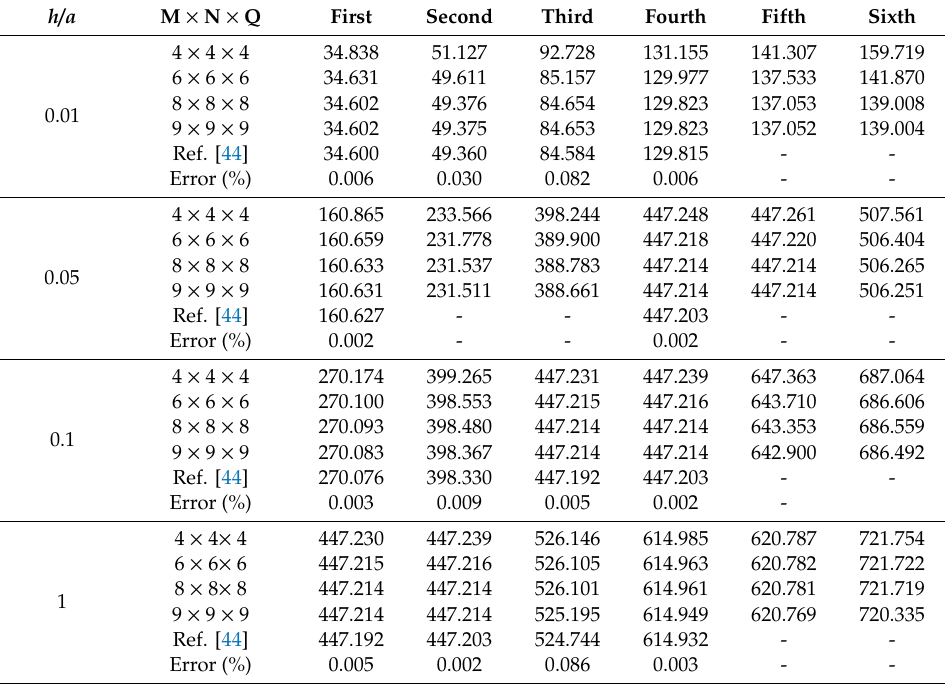
Table 2. The first six natural frequencies (Hz) of simply supported cross-ply (0 ◦ / 90 ◦ / 0 ◦ ) laminated square plate with di ff erent thickness-length